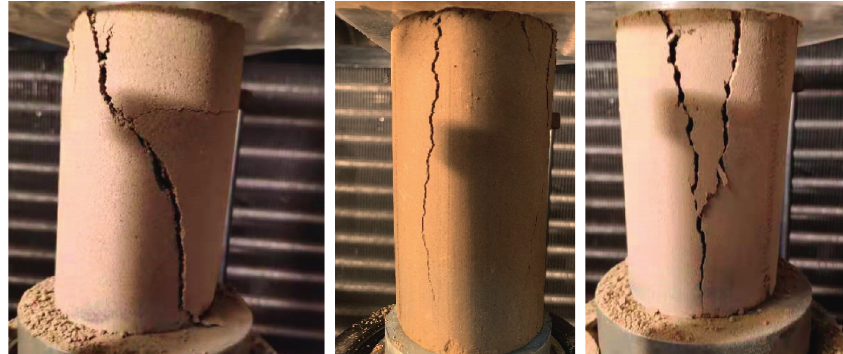
Figure 8: Samples damaged during unconfined compression test.